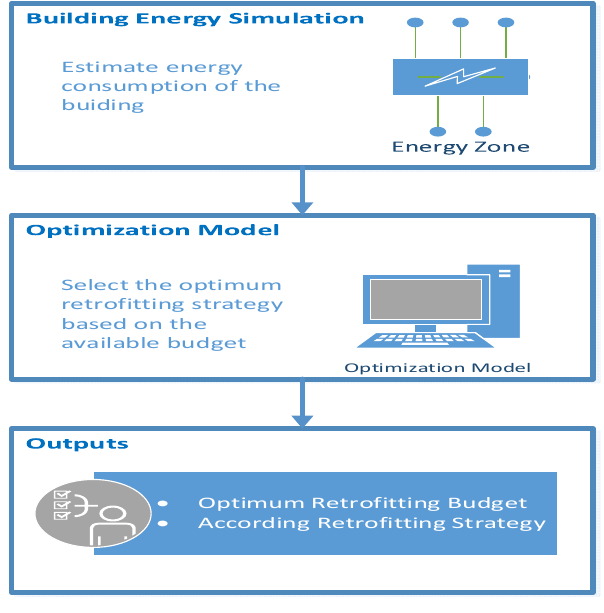
Figure 1. Overall flowchart of the study .